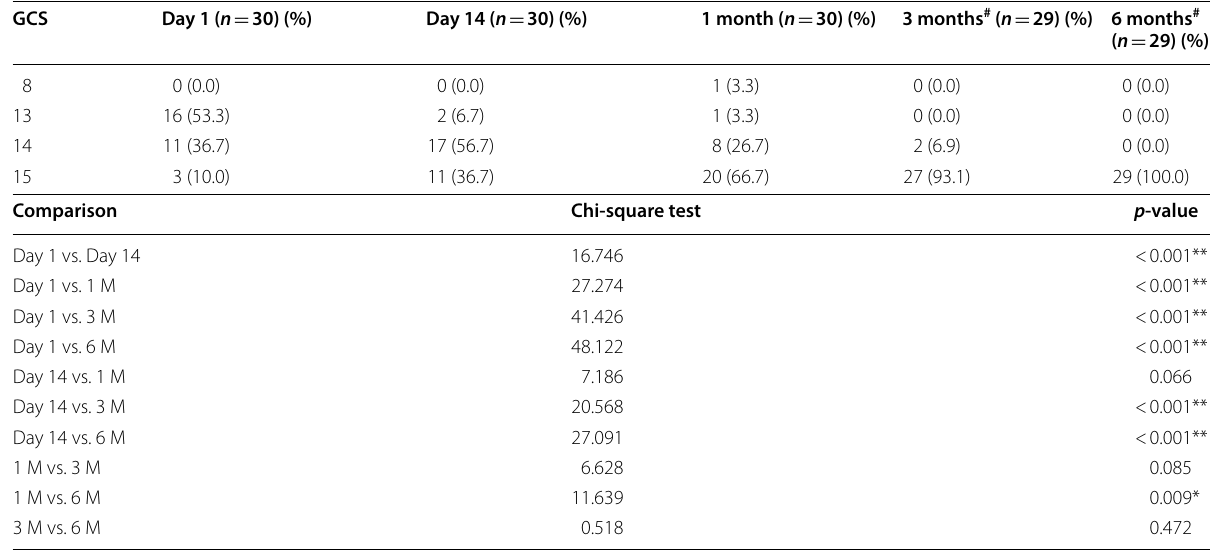
Table 2 A GCS values throughout the study duration. B Comparison between GCS values among study group ( n study